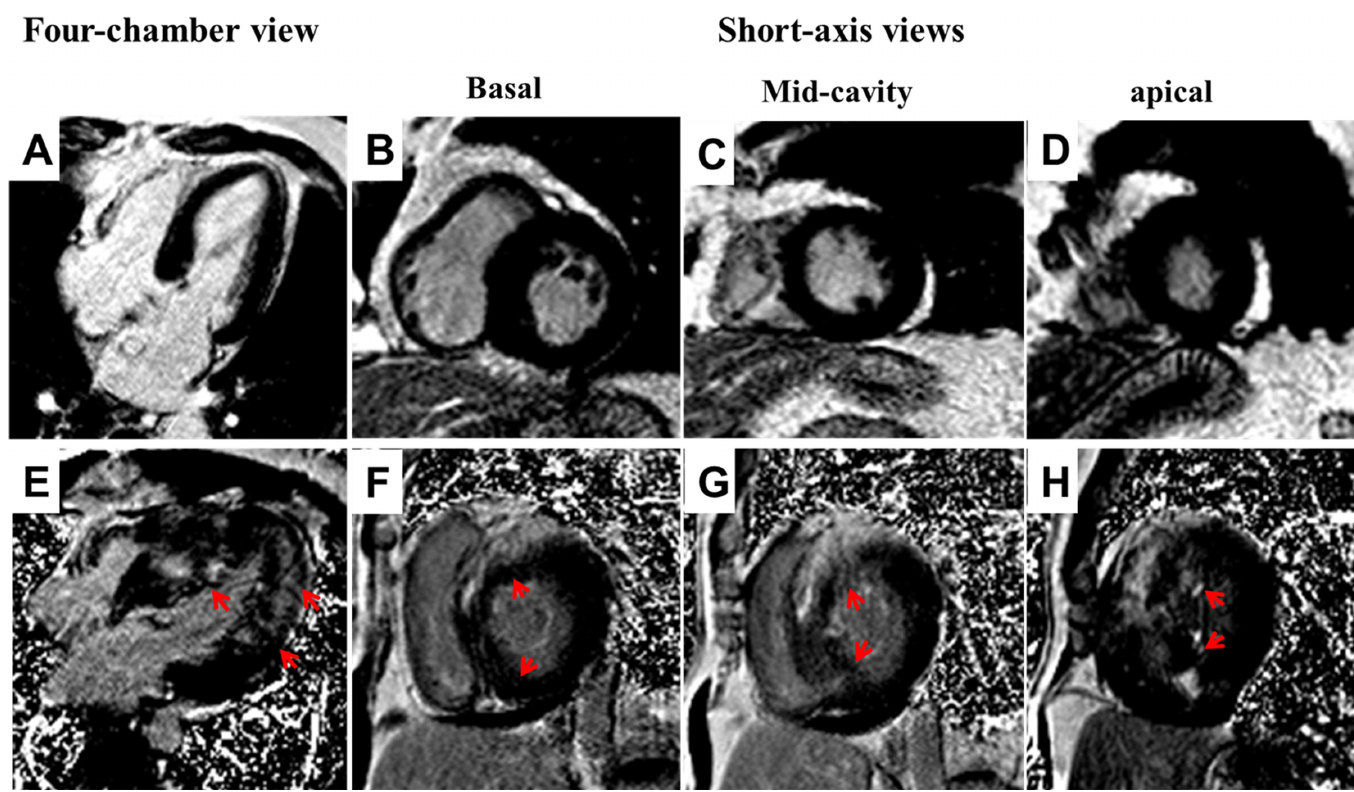
Fig 4. Representative LGE images of patients with extensive and without LGE. A 61-year-old woman with slightly elevated NT-proBNP plasma level (515.4pmol/L) and normal serum level of cTnI (0.006ng/ml), had no LGE detected in the 4-chamber view and end-diastolic short-axis views at basal, mid- ventricular and apical levels of left ventricle (A-D). A 47-year-old man with significantly elevated peripheral levels of NT-proBNP (2642.0pmol/L) and cTnI (0.321ng/ml), had extensive LGE (red arrows; LGE score, 46; LGE%, 67.6%) mainly involving the anterior, anteroseptal, septal, inferoseptal and inferior myocardium (E-H). Abbreviations as in Figs 1 and